Question: Which kind of chart has been used to present this data?
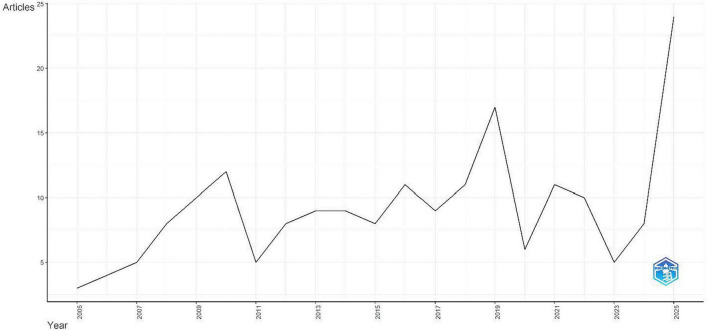
Answer: line